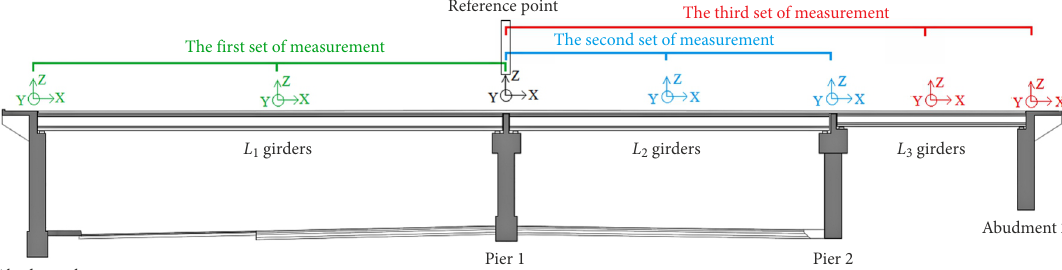
Figure 4. Application of modal testing with three